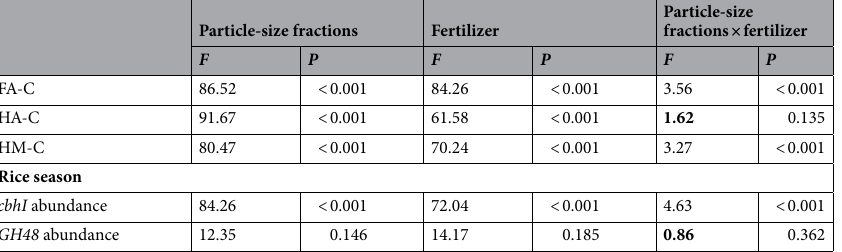
Table 1. Two-way ANOVA analysis C content of soil humus, abundance of cbhI and GH48 genes in the five soil particle-size fractions and fertilizer treatments. The data in bold were indicated the parameter were not significant affected by soil particle-size fractions, fertilizer treatments or their interaction ( p > 0.05). FA‑C carbon content of fulvic acid, HA‑C carbon content of humic acid, HM‑C carbon content of